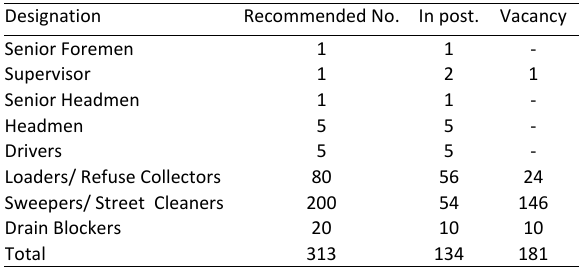
Table 2: Technical Personnel Involved in SWM (The Director of Environment and Enforcement, 2018)